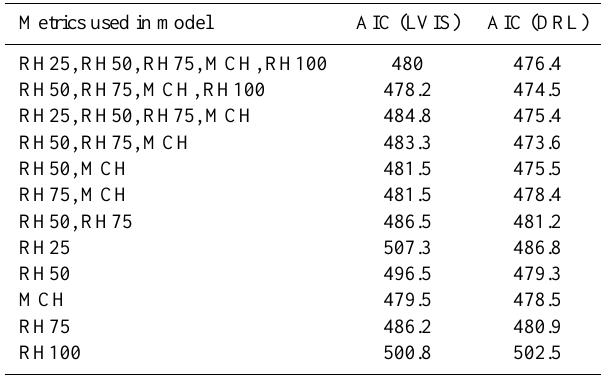
Table 2. Akaike information criterion (AIC). The smaller the AIC, the better the fit.